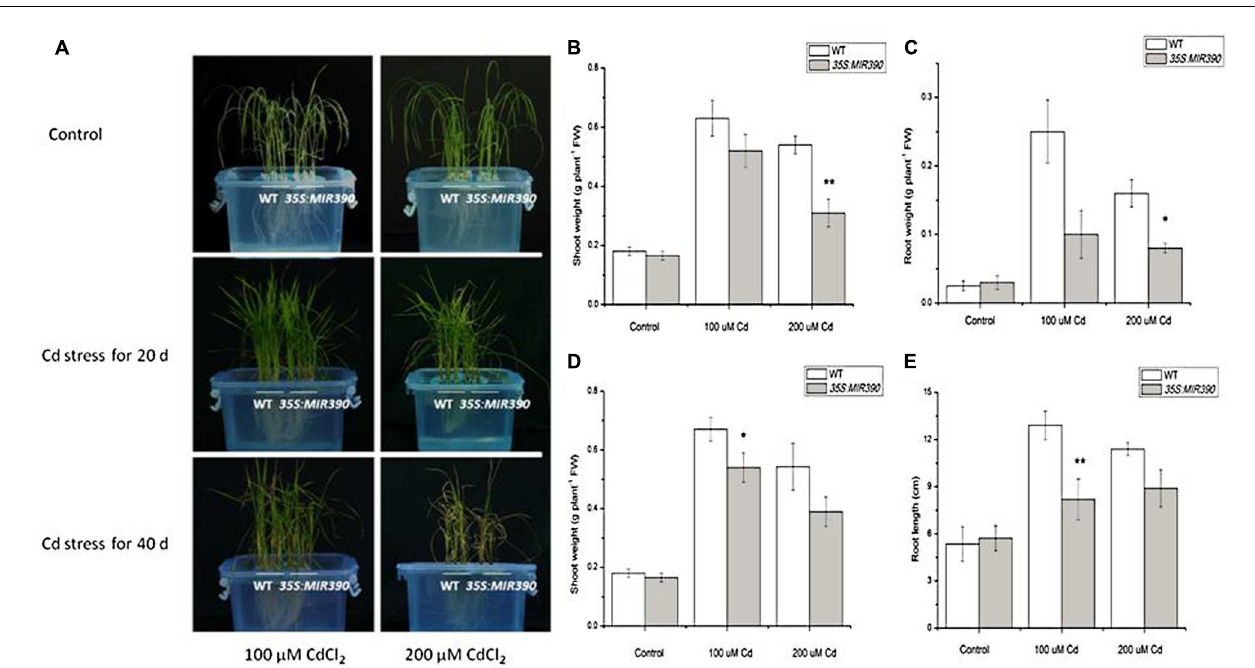
FIGURE 4 | Decreased Cd resistance of 35S:MIR390 transgenic rice plants. (A) Phenotypic comparison of wild-type and 35S:MIR390 transgenic rice plants under Cd stress. In each growth chamber, WT plants were grown on the left and 35S:MIR390 plants on the right. Upper panel: control, plants grown for 3 weeks under normal conditions before treatment. Middle panel: 3-weeks-old plants treated with 100 µ M CdCl 2 (left) and 200 µ M CdCl 2 (right) for 20 days. Lower panel: 3-weeks-old plants treated with 100 µ M CdCl 2 (left) and 200 µ M CdCl 2 (right) for 40 days. (B,C) Shoot fresh weight (FW) and root FW of wild-type and 35S:MIR390 transgenic plants grown under Cd stress for 20 days. (D,E) Shoot FW and root length of wild-type and 35S:MIR390 transgenic plants grown under Cd stress for 40 days. In (B–E) , significant differences from the wild-type as determined by the Student’s t -test are indicated ( ∗ P < 0.05, ∗∗ P < 0.01). Bars indicate